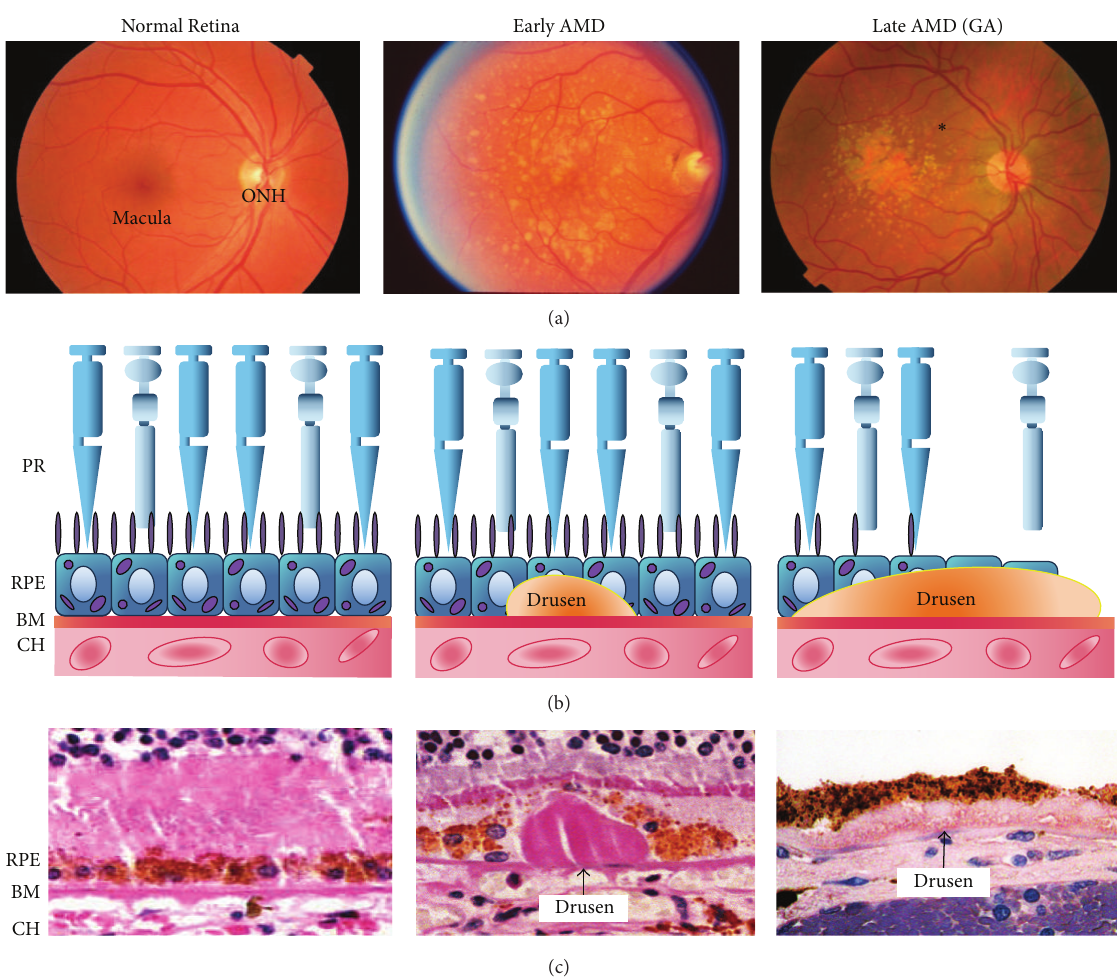
Figure 1: Clinical stages and signs of age-related macular degeneration. (a) Fundus photos demonstrate clinical features of AMD at different stages. Early AMD shows yellow extracellular drusen deposits surrounding macular area. Late AMD (GA) shows hypopigmentation or background darkening ( ∗ ) around drusen. A large number of drusen deposits are observed accumulated in the macular area. (b) Schematic diagramofdrusenaccumulationandRPE/photoreceptordegenerationfromearlytolatestageAMD(GA).(c)Stainingofhumanpostmortem donor eye tissues depicting normal, early AMD, and late AMD. Arrows point to different forms of drusen: a large hard drusen in an early AMD eye and a diffuse, soft drusen in a late AMD (GA) eye. GA, geographic atrophy; ONH, optic nerve head; PR, photoreceptors; RPE, retinal pigment epithelium; BM, Bruch’s membrane; CH, choroidal